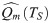
Fluorescence from EGFP in E. coli cell.(A) Fluorescence intensity (triangles) decays with time as a result of photodepletion. The fit (solid line) to an exponential decay function recovered an initial intensity F
0 = 336 kcps and a depletion rate coefficient k
D = 0.026 s-1. (B) Segmented Q-values Qm^(TS) for a segment time of T
S = 0.2 s with an average value of 0.025.